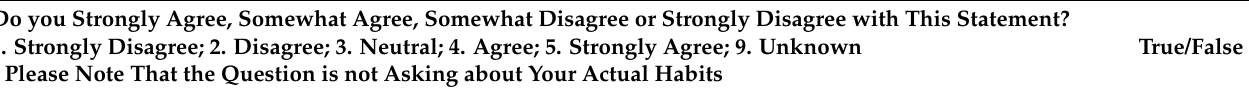
Table A1. Dietary knowledge questions and corresponding answers in the China Health and Nutrition Survey (CHNS).